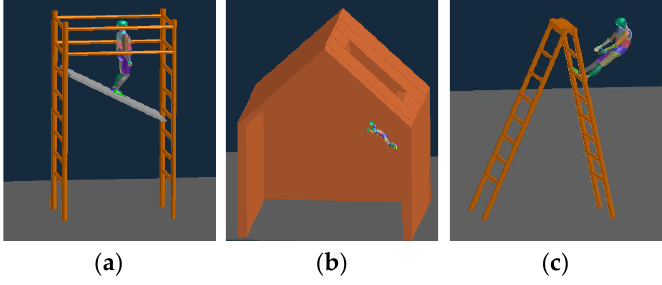
Figure 4. FFH motions in the dynamics simulations: ( a ) scaffold FFHs, ( b ) roof FFHs, and ( c ) ladder FFHs.